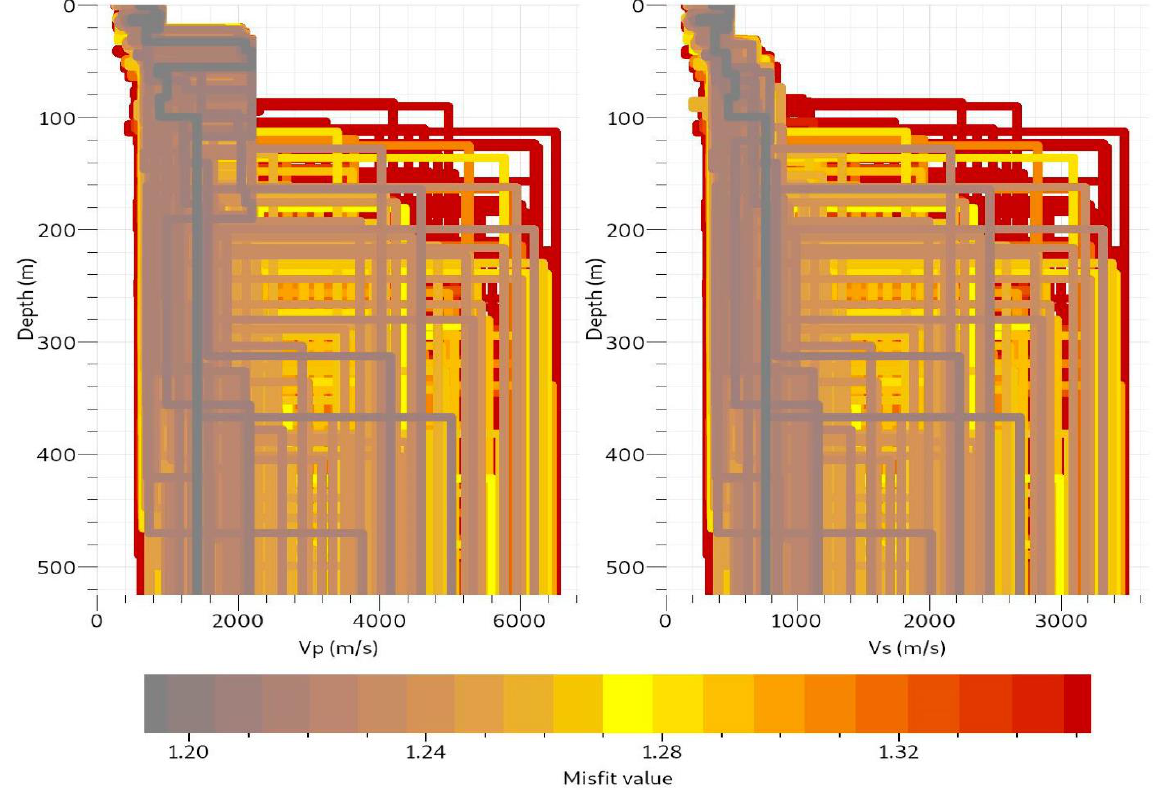
Figure 13. Velocity modeled for both Vp and Vs as obtained from the SPAC curve. Multiple layers were revealed, with a maximum depth of about 500 m.